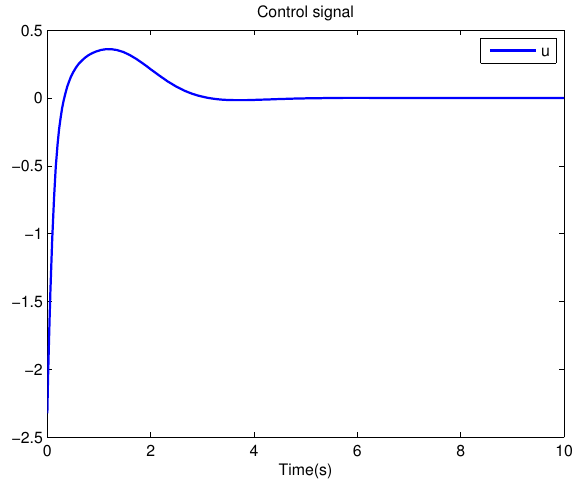
Figure 14. Robust control signal.